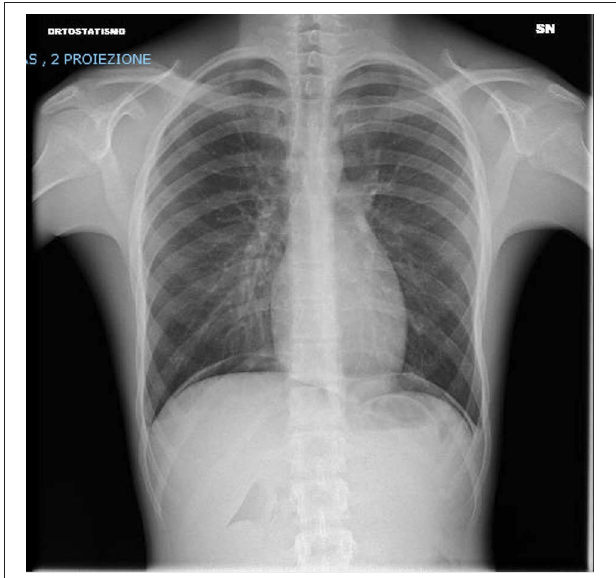
FIGURE 3 | Chest x-ray after 48h showing both lungs clear of significant parenchymal opacities and no signs of pleural effusions.